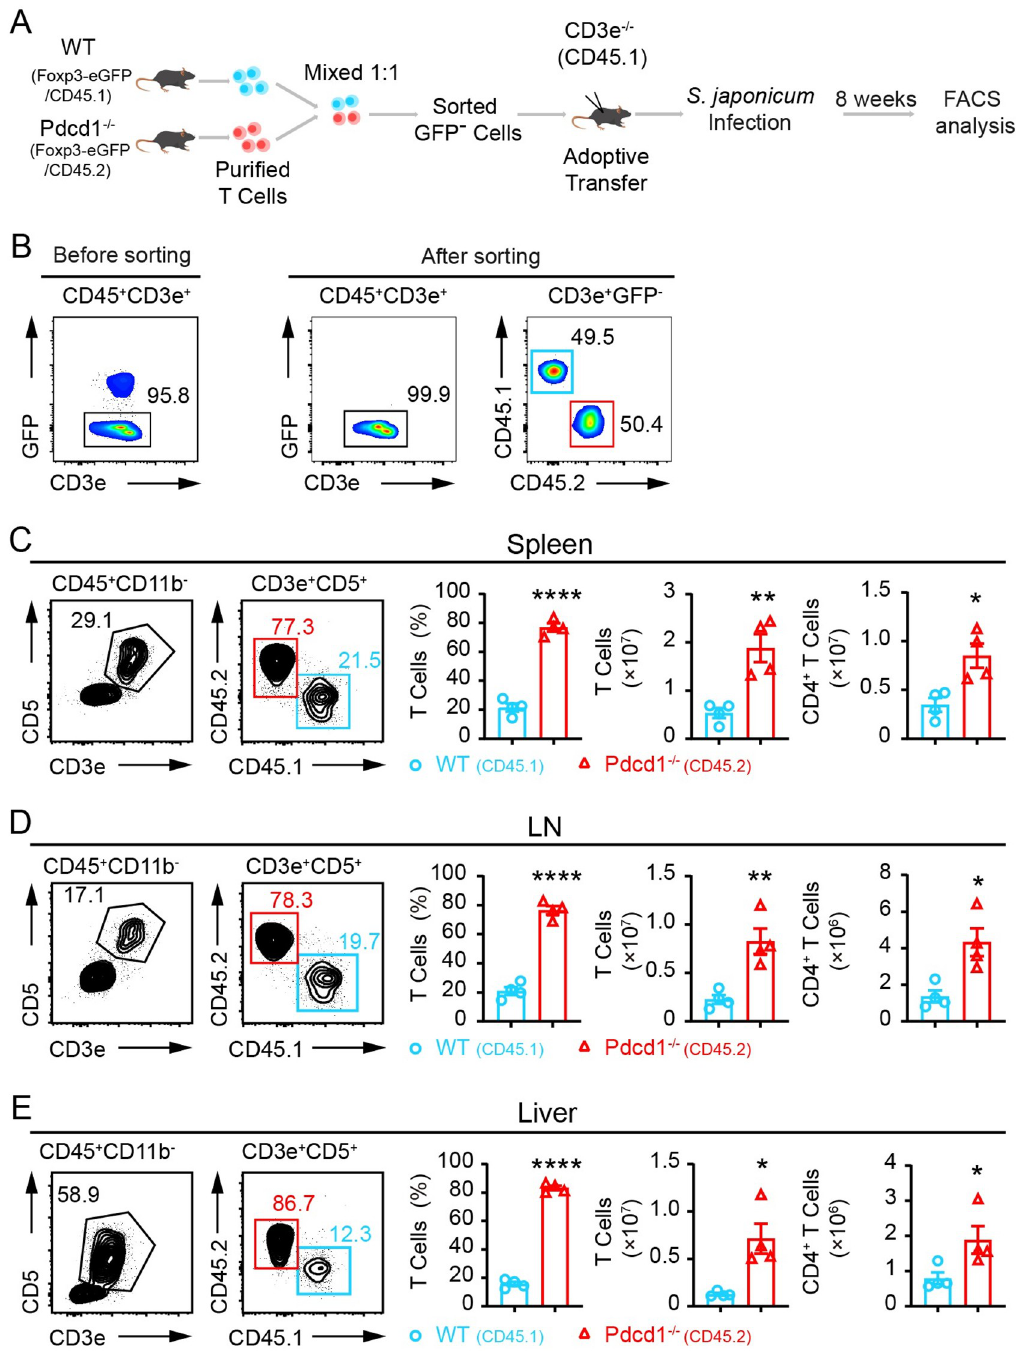
Fig 7. PD-1-deficient T cells dramatically outcompete wildtype T cells in vivo in the absence of natural Tregs during chronic S . japonicum infection. (A) Schematic presentation of experiments to compared WT and PD-1-deficient T cells in vivo in the absence of natural Tregs in S . japonicum infected mice. Purified total T cells from CD45.2 + Foxp3-eGFP + Pdcd1 −/− mice, and CD45.1 + Foxp3-eGFP + Pdcd1 +/+ control mice were sorted to obtain GFP-negative T cells, which were co-transferred into CD45.1 + CD3e −/− recipient mice with a 1:1 ratio and the recipient mice were infected with S . japonicum for 8 weeks. (B) FACS validation of cell sorting for GFP-negative T cells and mixture ratio between WT and PD-1-deficient cells before adoptive transfer into CD45.1 + CD3e −/− recipient mice (n = 4). (C) Comparison of WT and PD-1-deficient T cells in spleens of recipient mice 8 weeks after S . japonicum infection. (D) Comparison of WT and PD-1-deficient T cells in lymph nodes of recipient mice 8 weeks after S . japonicum infection. (E) Comparison of WT and PD-1-deficient T cells in livers of recipient mice 8 weeks after S .